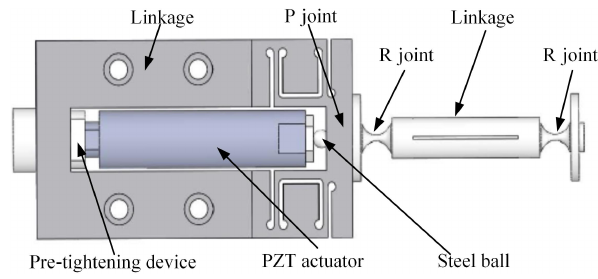
Figure 4. A single compliant